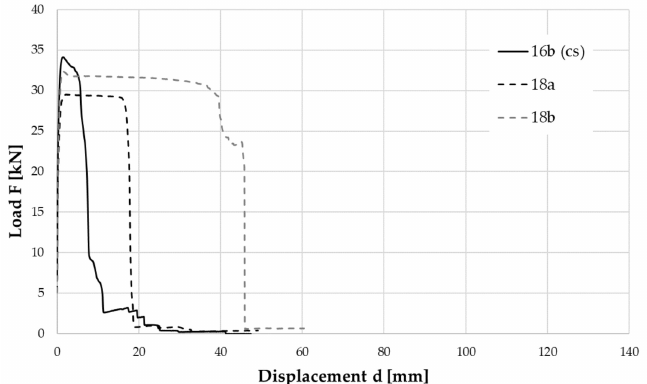
Figure 21. Tensile load-displacement response curves for samples 14a and 14b, without bridge layers and 18a and 18b, with bridge layers.